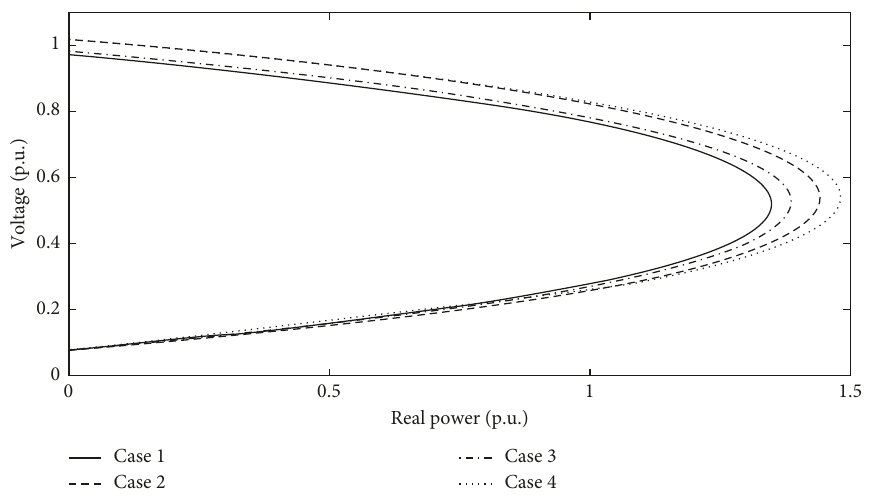
Figure 6: PV curves at the weakest bus of the IEEE 30-bus test system.